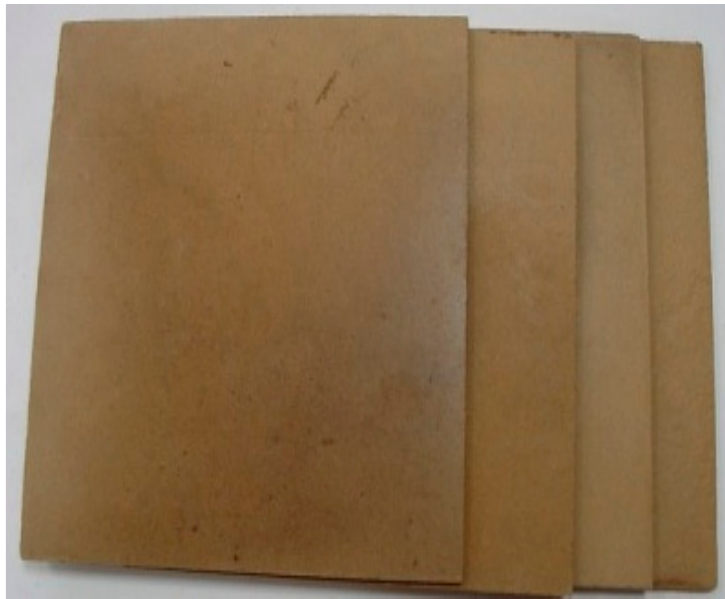
Figure 2. Giant reed–cement–starch panels.